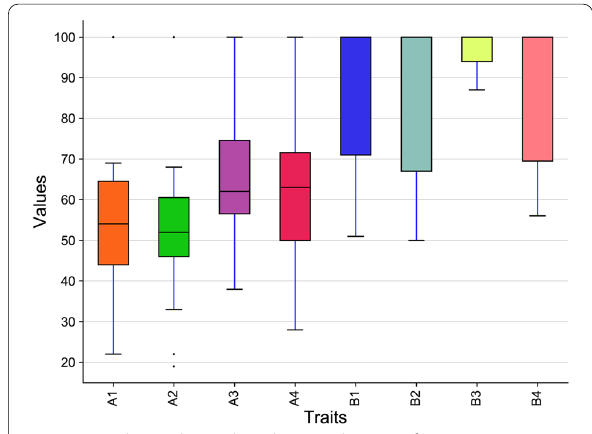
Fig. 2 Box plots indicate the relative reduction of seedling related-traits under both salinity levels of tomato landraces: (A1) relative reduction of shoot fresh weight at 4